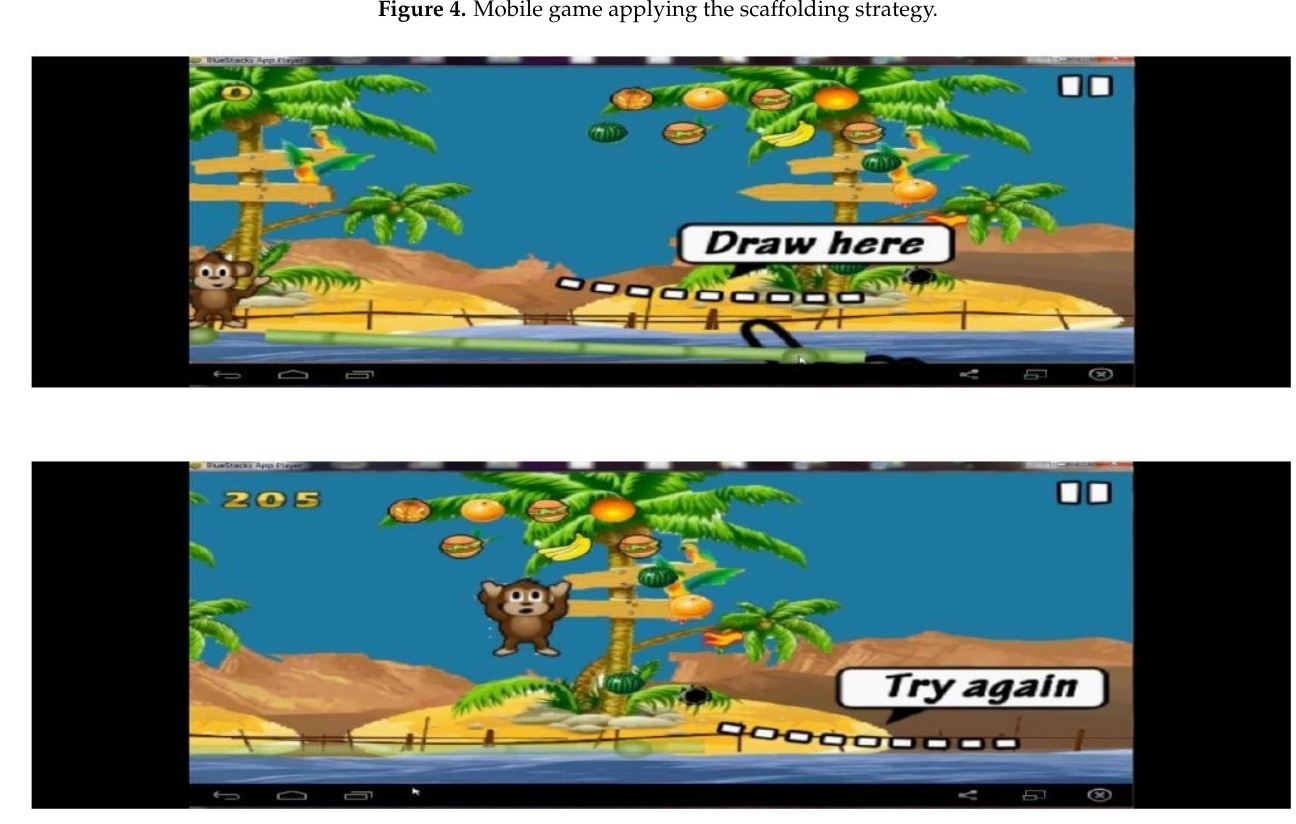
Figure 5. Mobile game applying the scaffolding